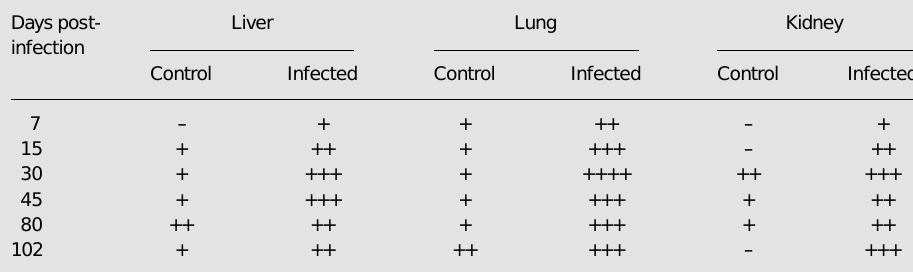
Table 1 - Intensity of IgG deposits detected by immunoperoxidase staining using biotinylated goat anti- hamster IgG antibody in the liver, lung and kidney of hamsters infected with 2 x 10 7 amastigotes of Leishmania ( L. ) chagasi and non-infected control animals at different times of infection. - = Negative. Intensity of positive reactions graded from + through ++++. Data are reported as the mean of 2-4 animals/group. Days